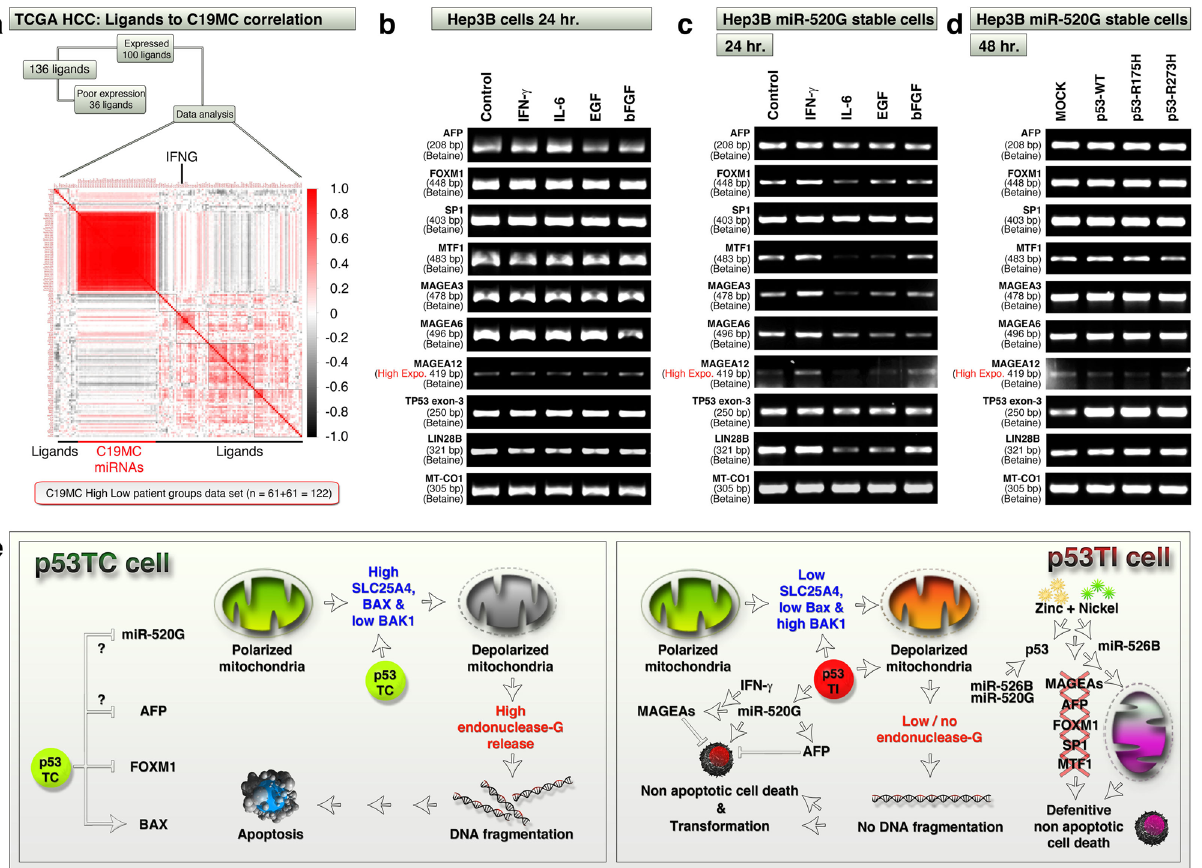
Figure 7. IFN-γ co-operates with miR-520G to upregulate MAGEAs, MTF-1 and FOXM1. ( a ) 100 expressing ligand mRNAs (cytokines, chemokines and so on) out of 136 from TCGA-LIHC data (RNA-seq data integrated to miRNA-seq from patients who had high versus low cumulative C19MC miRNA expression) were correlated to C19MC miRNAs to pick the top positively correlated IFN-γ mRNA. Insignificant and no correlations were color coded as white. ( b,c ) A panel of indicated gene mRNAs were examined for expression changes in response to indicated cytokines along with IFN-γ at 24 h time point in Hep3B untransfected cells (Panel- b ), and C19MC miRNA-520G stably transfected cells (Panel- c ). Note the differences between panels b and c. ( d ) Wild-type or mutant p53s does not co-operate with miR-520G to change the expression of any of the indicated genes considerably except MTF-1. ( e ) Schematic representing the cell death and transformation signaling differences between p53TC and p53TI cells. The apoptotic/non-apoptotic cells and DNA were created using